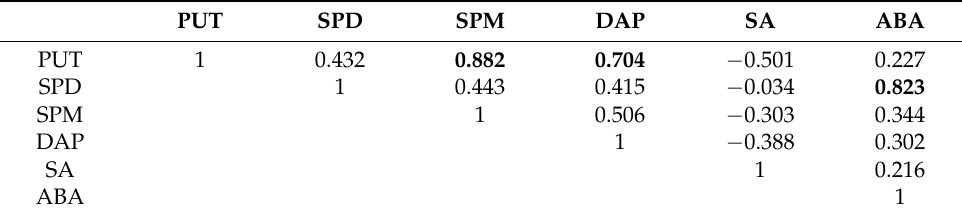
Table 4. Correlation analysis on the polyamine, salicylic acid and abscisic acid contents in the roots of wheat plants. Correlations significant at 0.05 are highlighted in bold. DAP: 1,3-diaminopropane; PUT: putrescine, SPD: spermidine, SPM: spermine, SA: salicylic acid; ABA: abscisic acid. PUT SPD SPM